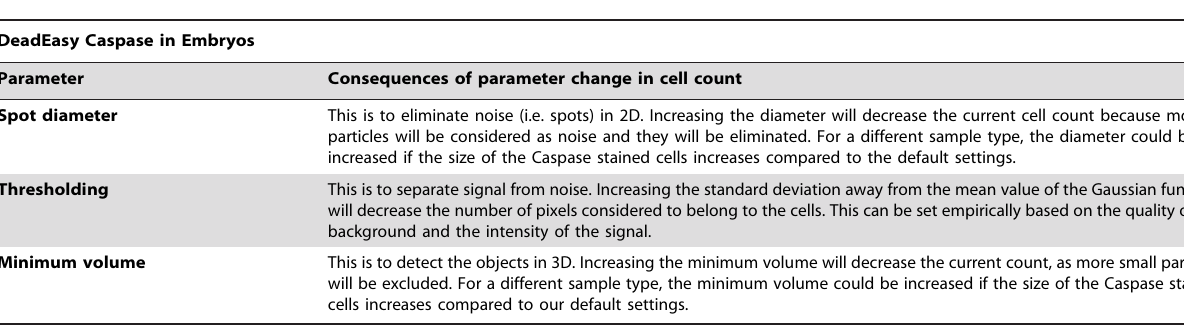
Table 3. Parameters that can be altered by the user and the